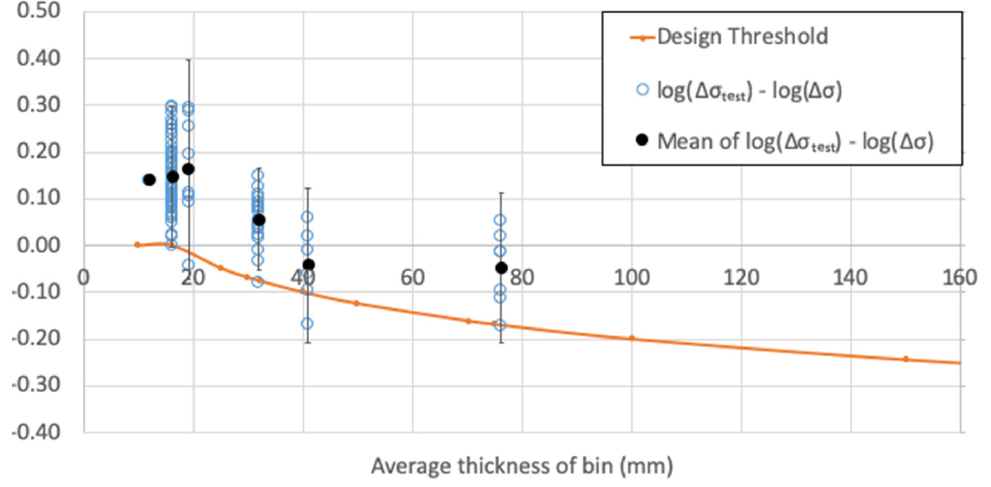
Figure 18. Data analysis of in-air tubular joints. Figure 20. Data analysis of in-air tubular joints . Figure 20. Data analysis of in-air tubular joints .